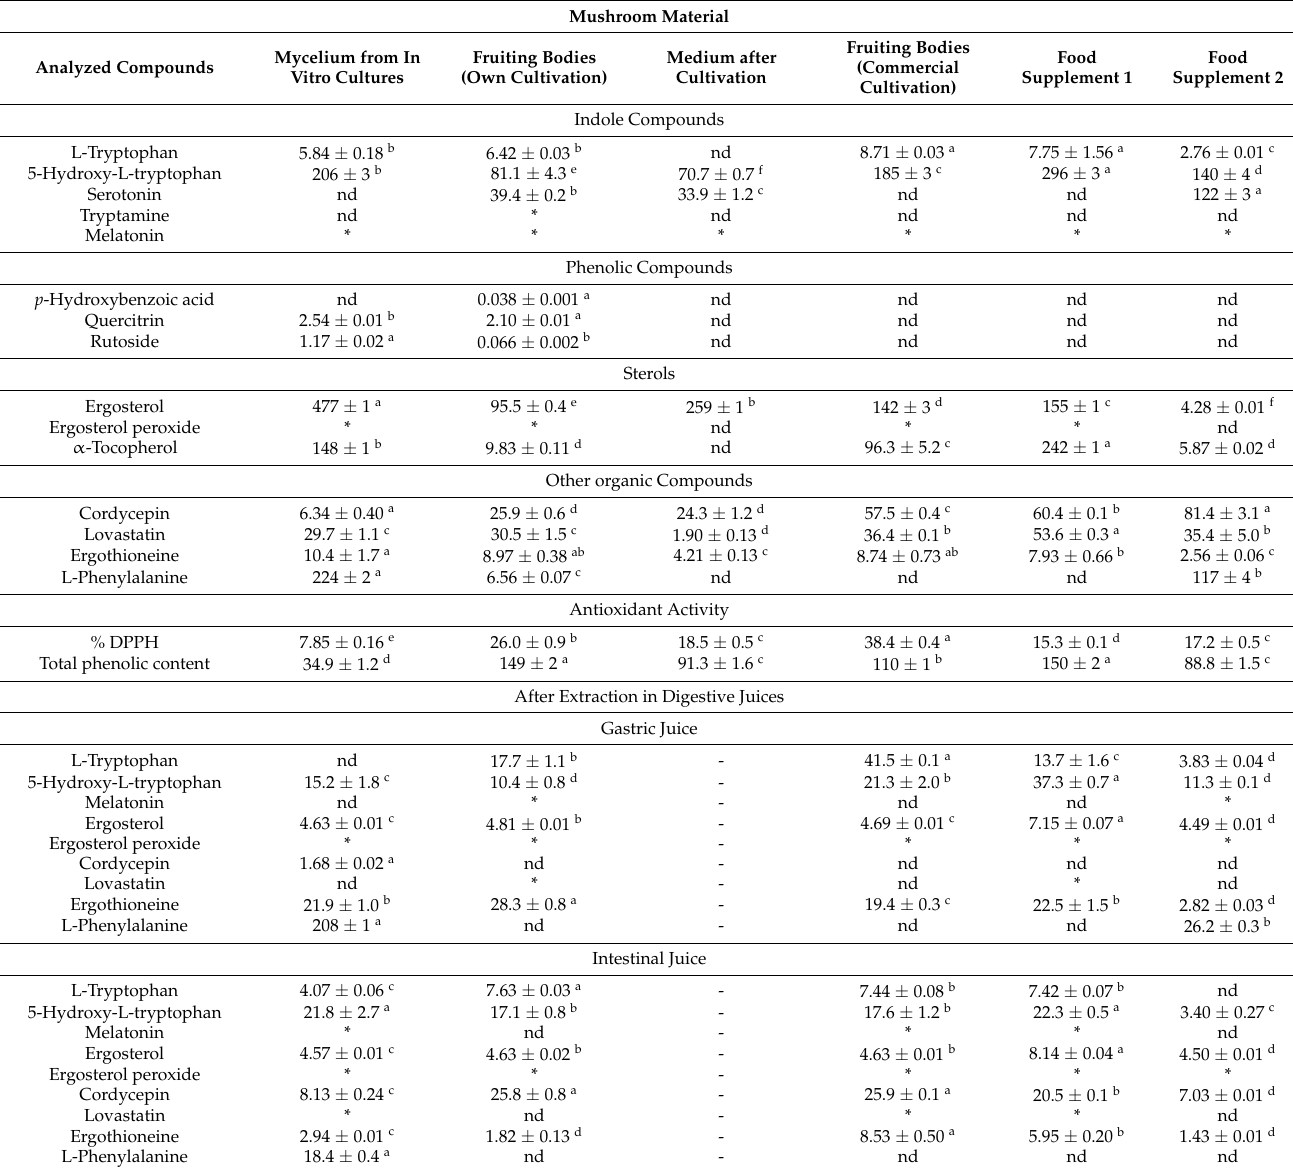
Table 2. Chemical compounds in analyzed samples of Cordyceps militaris [mg/100 g